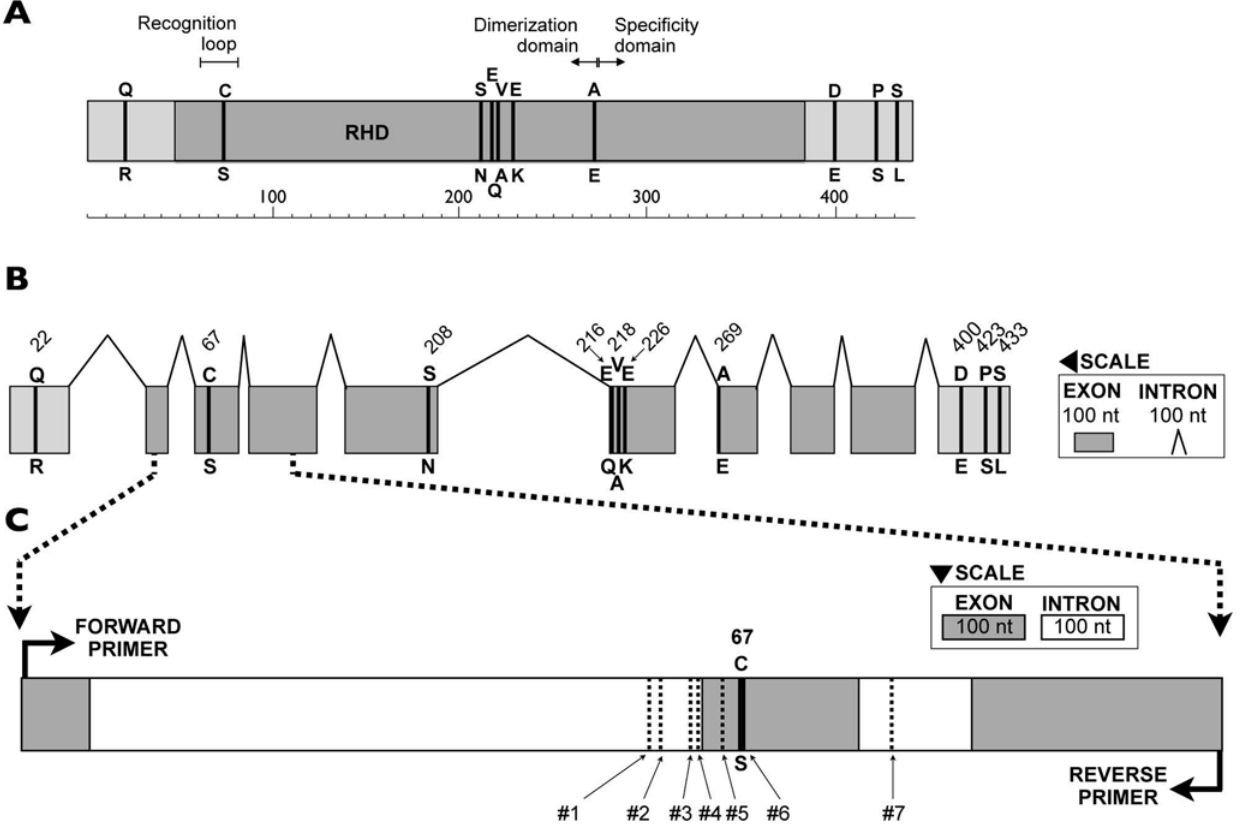
Figure 2. Location of polymorphic positionsin theNv-NF- k B protein andgene. (A) As indicated, tenprotein-coding differences were identified in a comparison of laboratory strain-derived Ser67 and Cys67 alleles. Six of the variable residues are in the highly conserved Rel Homology Domain (RHD). At each variable position, the amino acid encoded by the Cys67 allele is depicted above the diagram, and the amino acid encoded by the Ser67 allele is depicted below the diagram. The full-length Nv-NF- k B protein is 440 amino acids long (scale bar at bottom). (B) The locations of polymorphic amino acids are shown relative to the structure of the Nv-NF- k B gene. (C) The region of the Nv-NF- k B gene amplified in the population genetic survey extends from exon two to exon four, including two introns. The variable nucleotide positions identified in this survey are numbered from 1–7. doi:10.1371/journal.pone.0007311.g002 PLoS ONE |